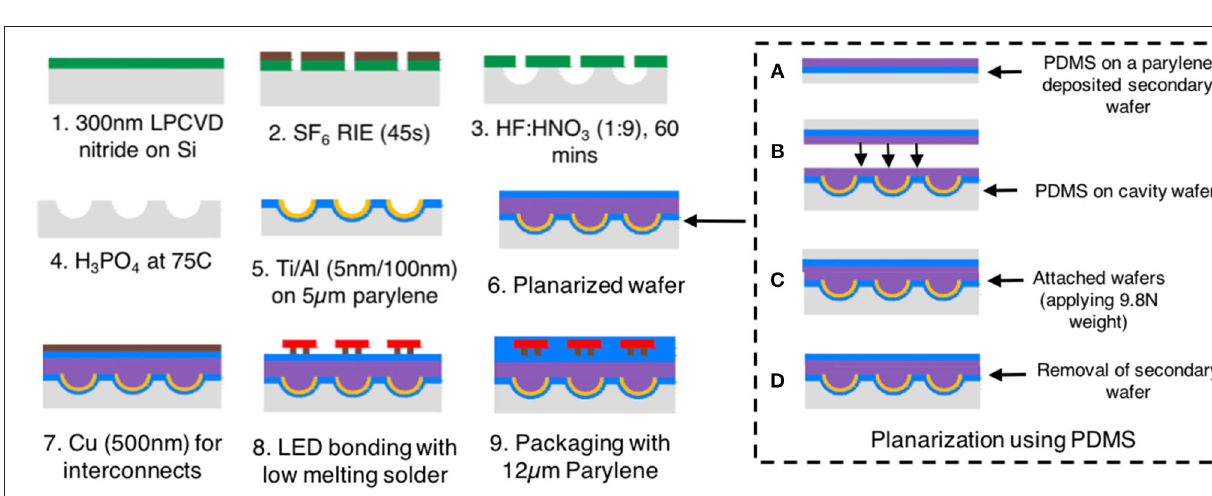
FIGURE 2 | A simplified fabrication process flow. Steps (A–D) illustrate the planarization